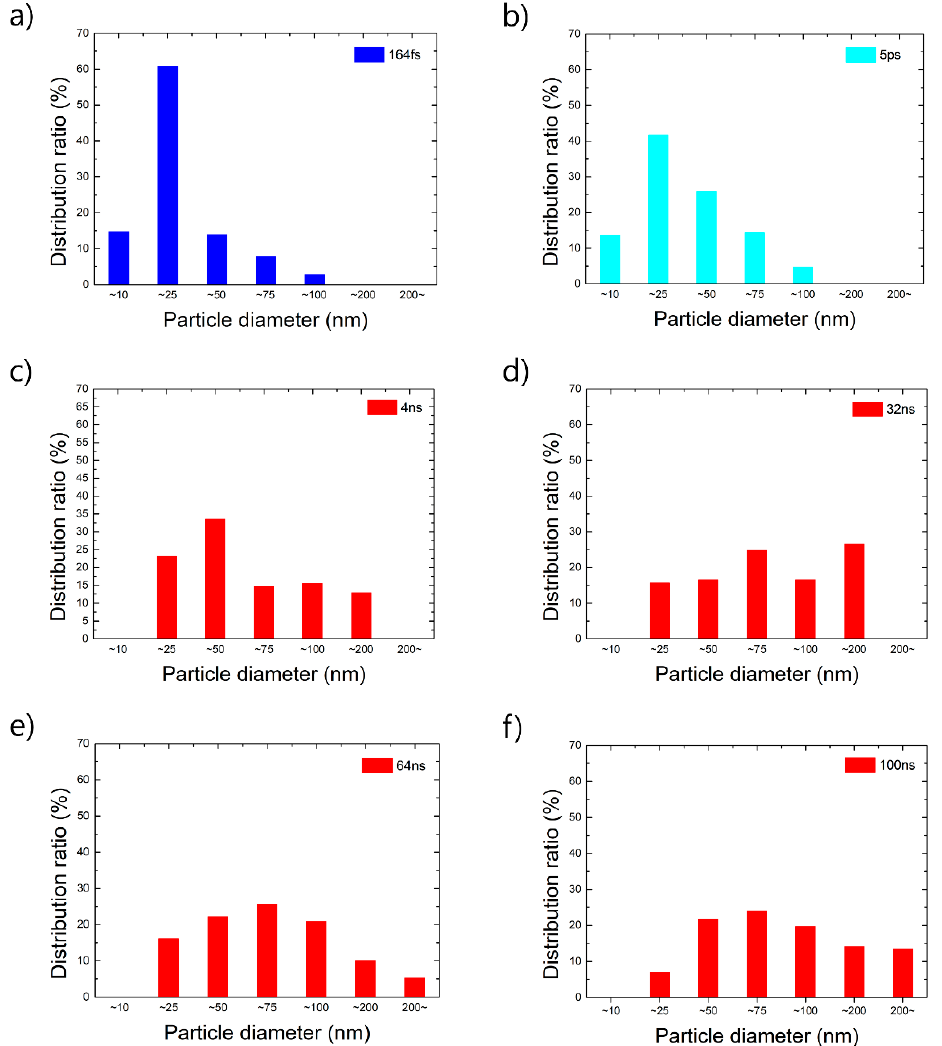
Figure 6. Size distribution of Ag nanoparticles. ( a ) 164 fs, ( b ) 5 ps, ( c ) 4 ns, ( d ) 32 ns, ( e ) 64 ns, and ( f ) 100 ns pulse widths.